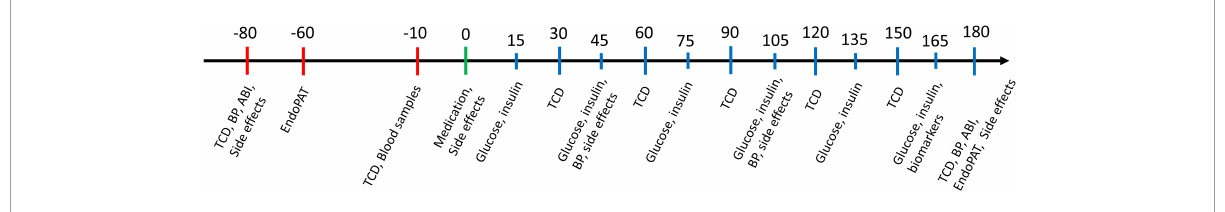
FIGURE1 Trial day flowchart. Time shown in minutes with medication time point set to 0 min. Red bars indicate pre-medication methods, green bar indicates medication time point and blue bars indicate post-medication methods. ABI, ankle brachial index; BP, blood pressure; TCD, transcranial